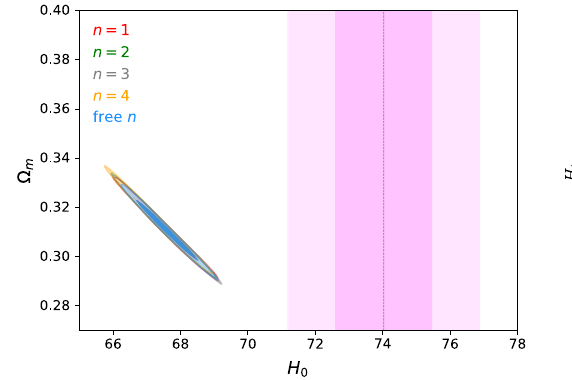
Fig. 1 The constrained 2-dimensional parameter spaces ( H 0 , (cid:11) m 0 ) and (log 10 f R 0 , H 0 ) from the “C” dataset are shown for HS f ( R ) models with n = 1 (red), 2 (green), 3 (grey), 4 (orange) and free n